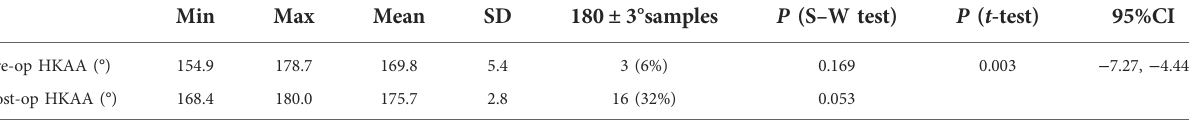
TABLE 1 Pre-operation and post-operation HKAA comparison.